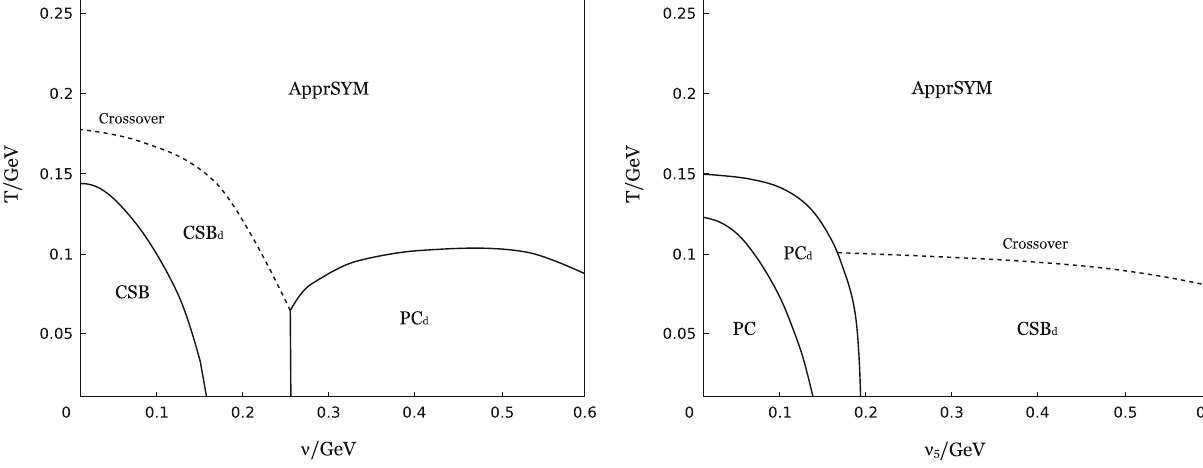
Fig. 8 The ( ν, T )-phase portraits at μ = 200MeV ,ν 5 = 200MeV (left panel) and at μ = 200MeV ,ν = 200MeV (right panel), respectively. The dashed line corresponds to a cross-over region of the phase diagram